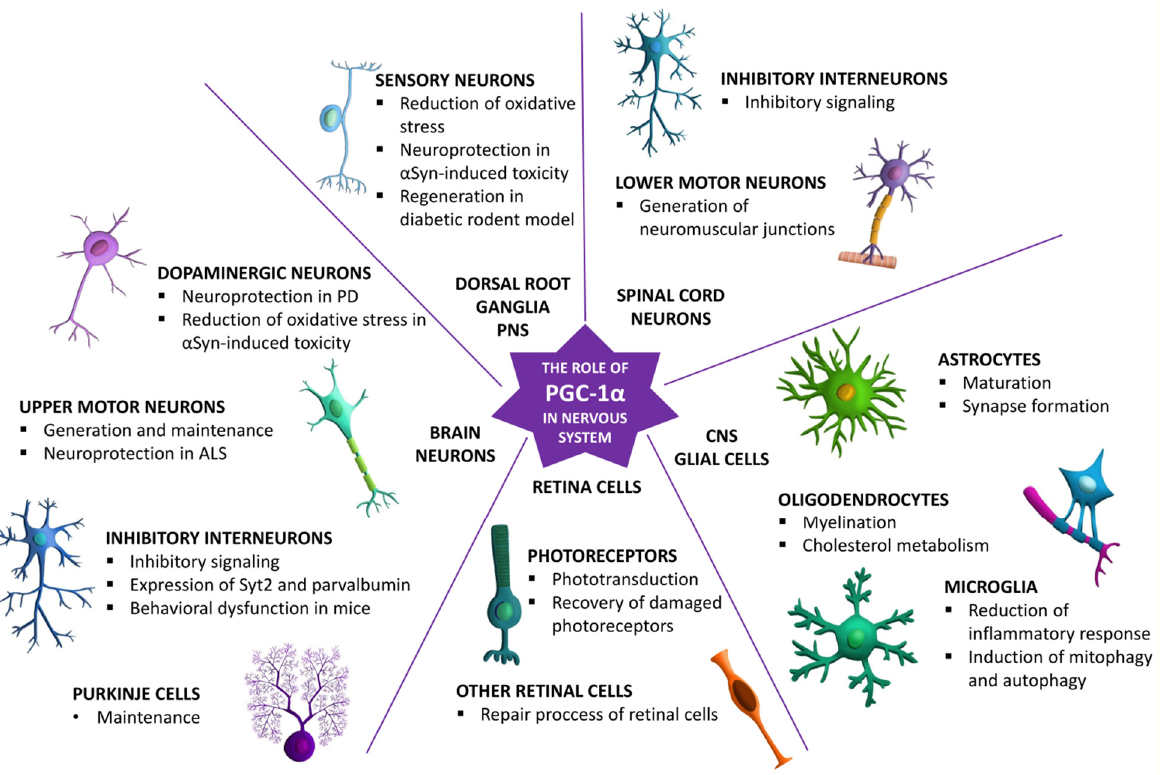
Figure 2. The key roles of PGC-1 α in the maturation, functioning, and survival of different cell types across the nervous system.